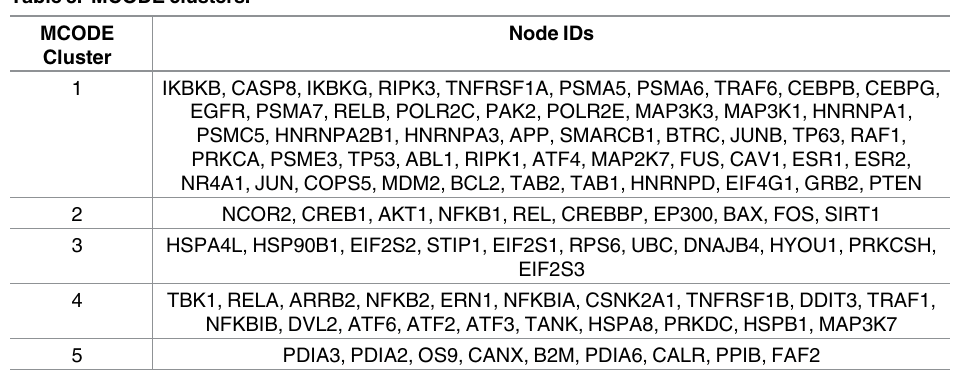
Table 3. MCODE clusters.